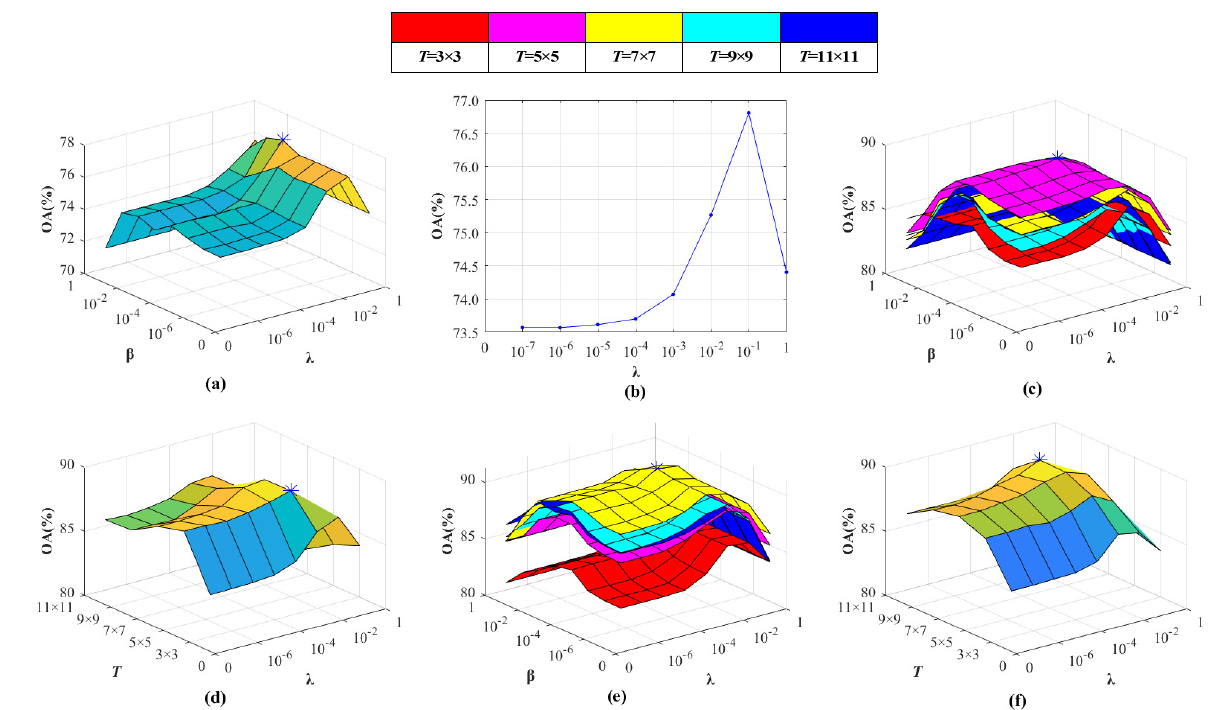
Figure 2. Classification performance for ( a ) DKCRT, ( b ) KCRT, ( c ) JDKCRT, ( d )KCRT-CK, ( e ) WSSDKCRT, and ( f ) WSSKCRT under different parameters. Table 2. Optimal parameter settings for each method.